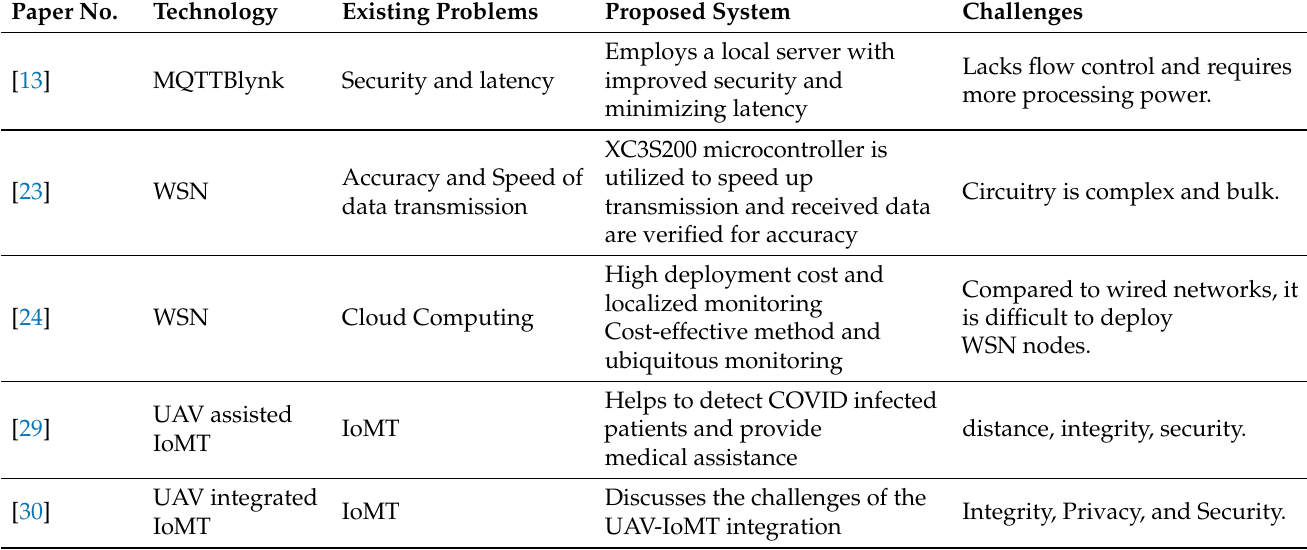
Table 1. Comparison of the significant existing